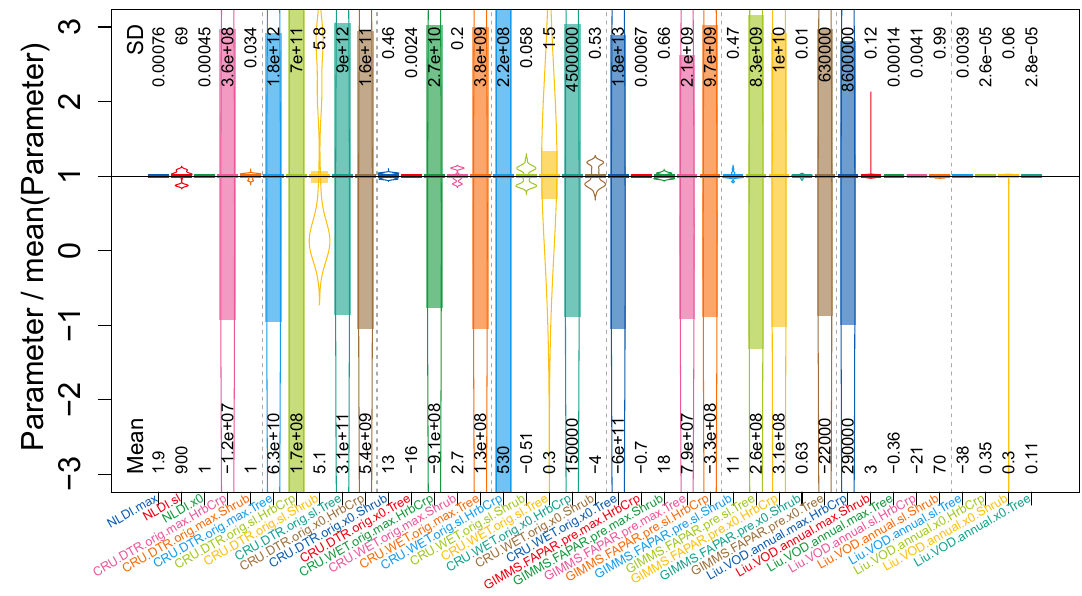
Figure A3. Uncertainty in parameters of SOFIA model SF.124421 after genetic optimization. Shown are distributions (outlines), mean values ( = 1), and confidence intervals (bars) for the mean values for each parameter. Plotted are parameters from equally well-performing parameter sets (i.e. >0.8 · normalized likelihood NLL, NLL = LL/max(LL) with LL = exp( −